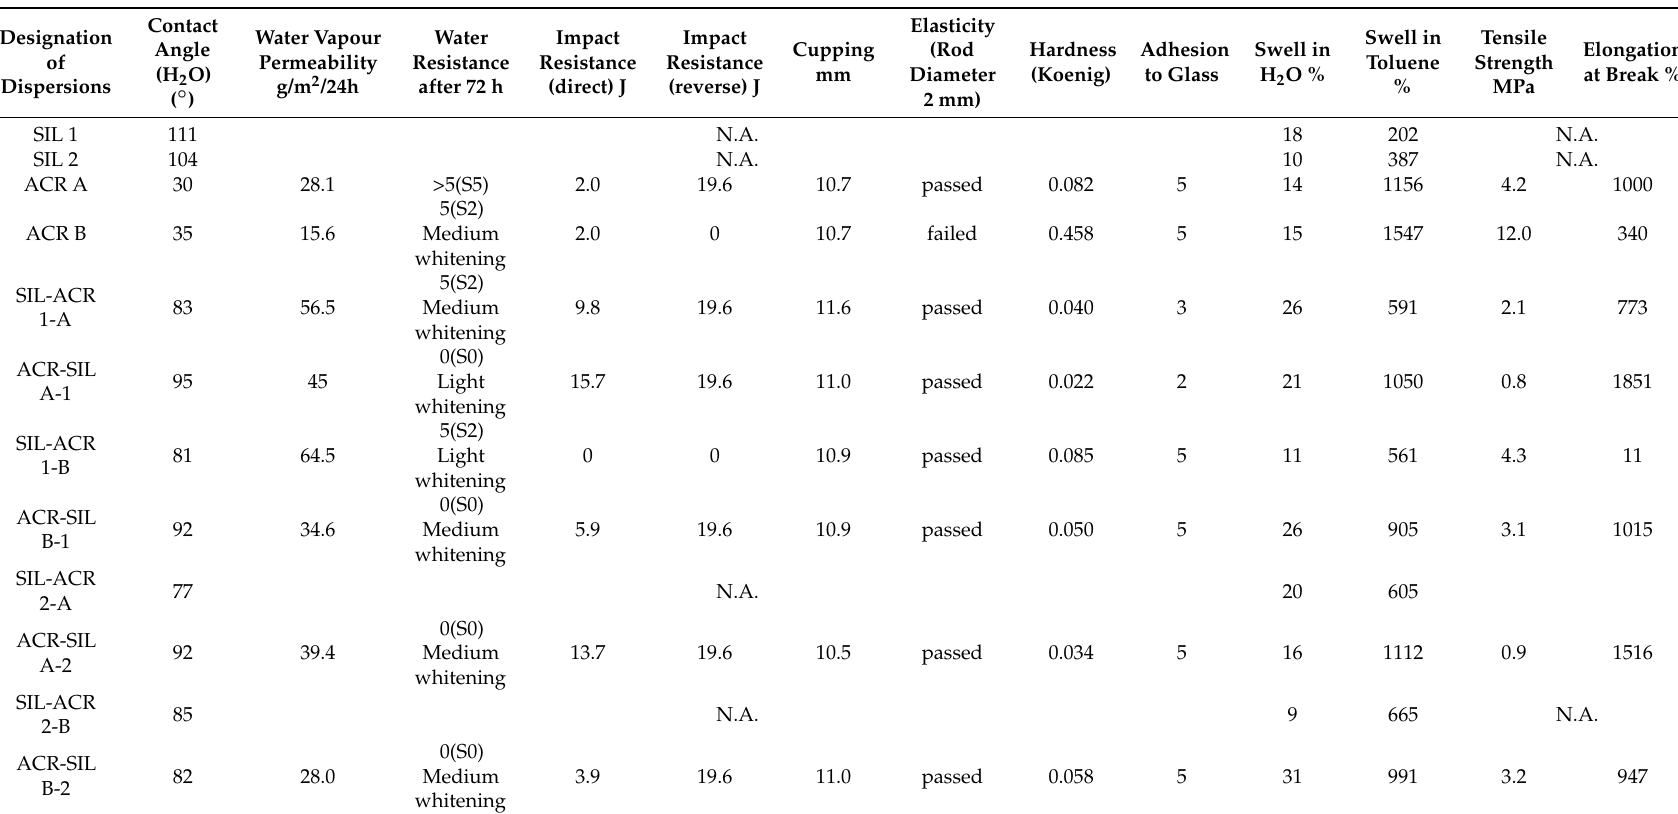
Table 2. Properties of coatings and films made from hybrid SIL-ACR and ACR/SIL dispersions and of starting SIL and ACR dispersions. N.A. = Not Applicable because dispersion did not produce continuous coating or/and film at R.T. Although SIL-1 and SIL-2 dispersions did not produce continuous a mechanically strong coatings, it was possible to measure their contact angles on very mechanically weak coats that were cast on glass Petri